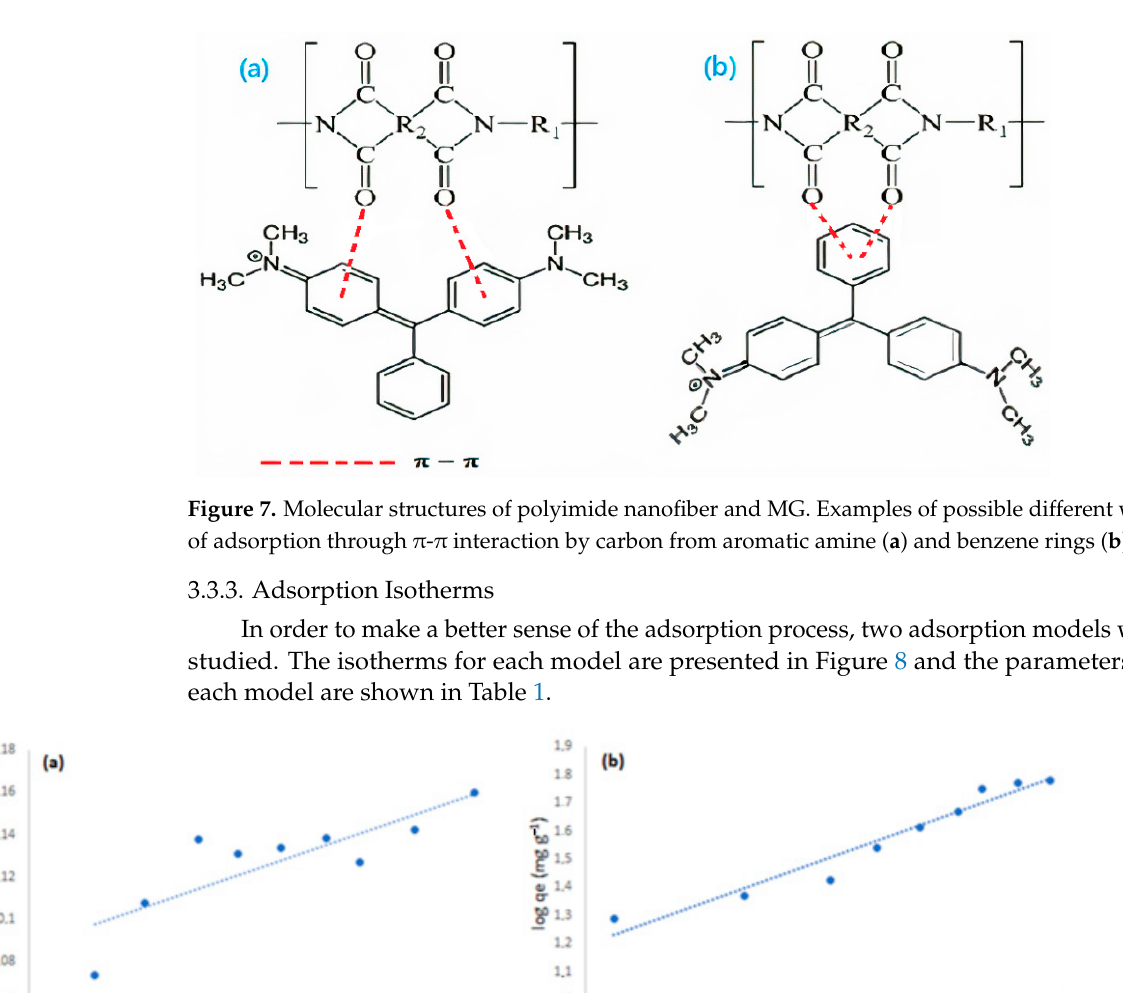
Figure 6. pH PZC calculated for polyimide nanofiber under pH variation for 2.0 mg of nanofiber. The data in Figure 7 indicates a schematic adsorption interaction between MG and the polyimide, based on the pH of the solution, the calculated pH PZC as well as the data from the infra-red analyses.